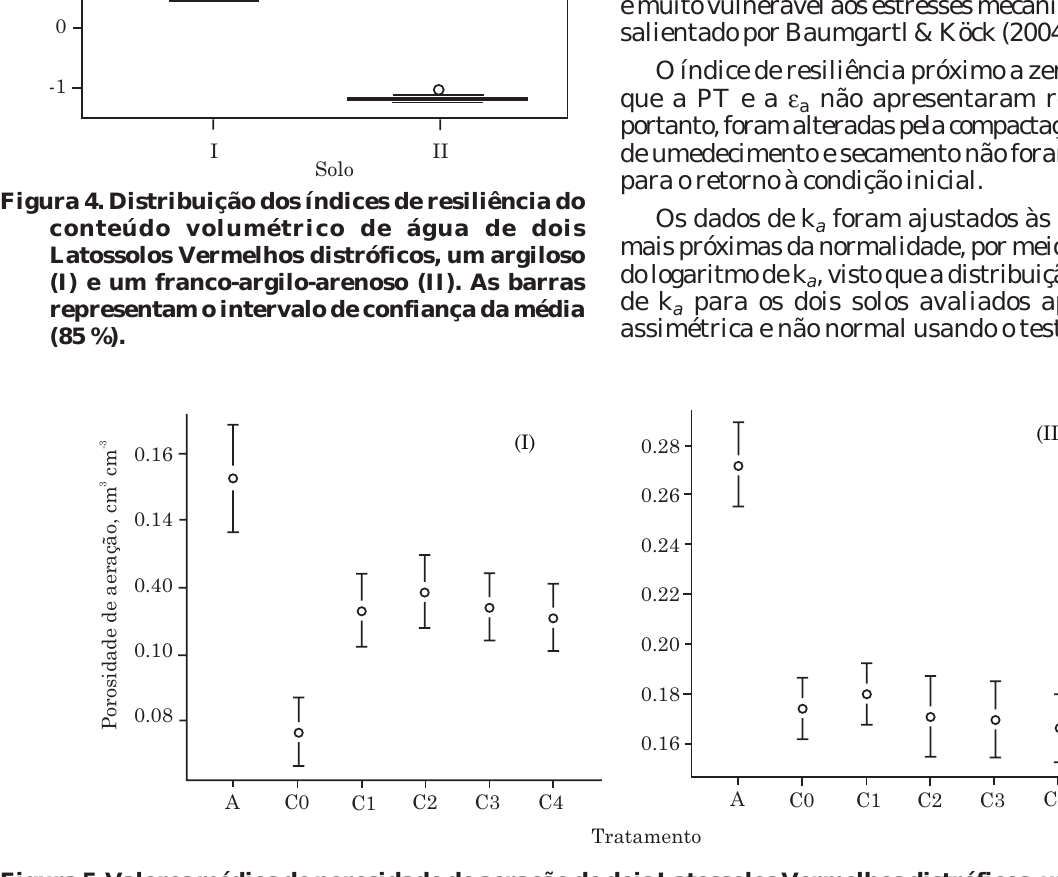
Figura 5. Valores médios de porosidade de aeração de dois Latossolos Vermelhos distróficos, um argiloso (I) e um franco-argilo-arenoso (II), para os tratamentos A, C0, C1, C2, C3 e C4. As barras representam o intervalo de confiança da média (85